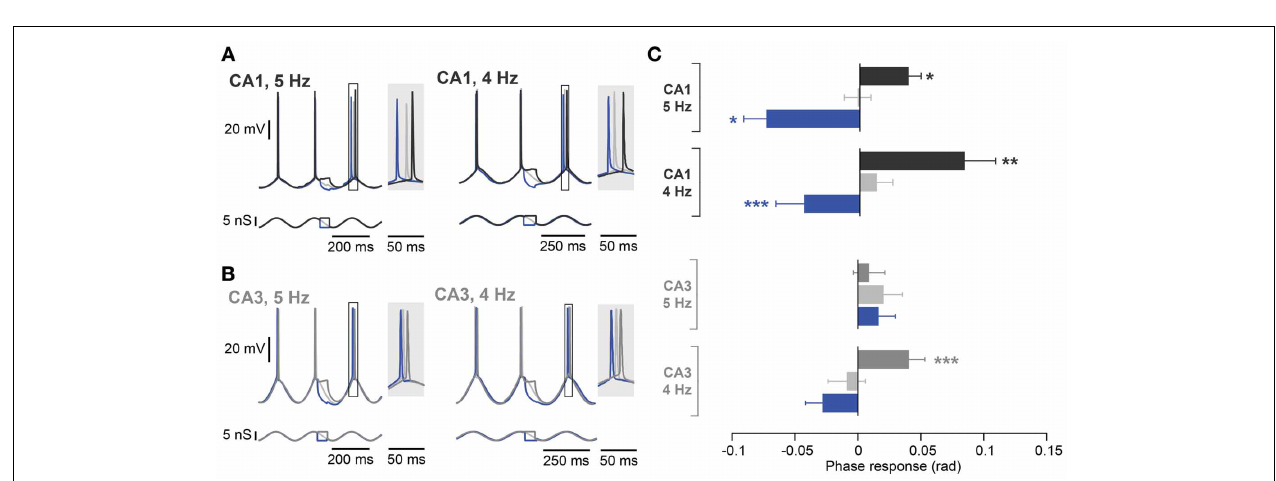
FIGURE 5 | Frequency dependence of spike phase control recorded at 5Hz and 4Hz. (A) Representative responses of a CA1 neuron (top traces) to inputs optimized for modulating I h during induced oscillation (bottom traces) at 5Hz (left panel) and 4Hz (right panel). The spike phase shifts (boxes) are enlarged in the shaded insets. (B) Same as in (A) but from a CA3 neuron with a resonance peak > 1Hz. (C) Average phase responses of CA1 and CA3 pyramidal neurons for both a 5 and 4Hz oscillation. In CA1, a depolarizing step delayed the following spike,